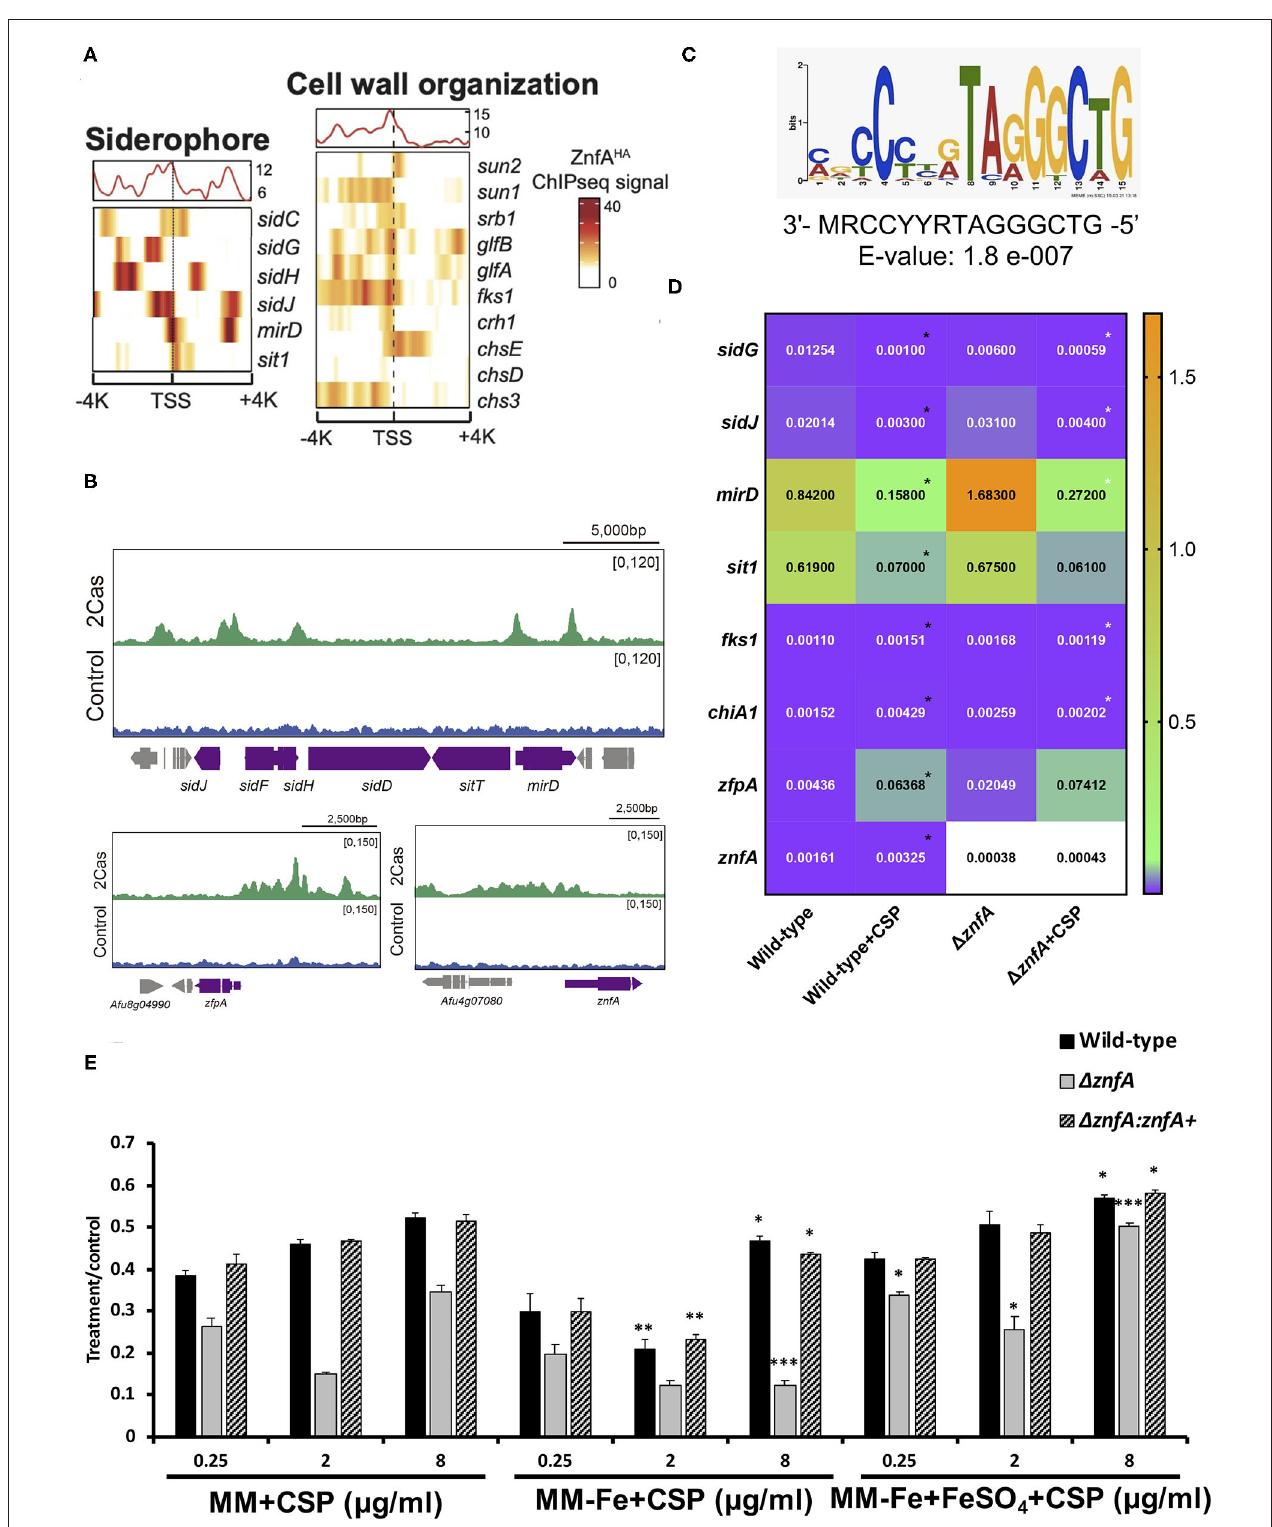
FIGURE 3 | ZnfA binds to the promoter regions of specific genes encoding for siderophore biosynthesis and transport and cell wall remodeling after caspofungin exposure. Chromatin immunoprecipitation coupled to DNA sequencing (ChIP-seq) of the ZnfA:3xHA strain when grown for 16h at 37 ◦ C and treated or not with 2 µ g/ml of CSP for 1h was assessed. (A) Heat map depicting ChIP-seq signal for genes involved in siderophore biosynthesis and transport and cell wall organization. (B) Selected examples of peaks identified in the promoter region of genes belonging to the siderophore biosynthetic cluster, zfpA and znfA genes in control and